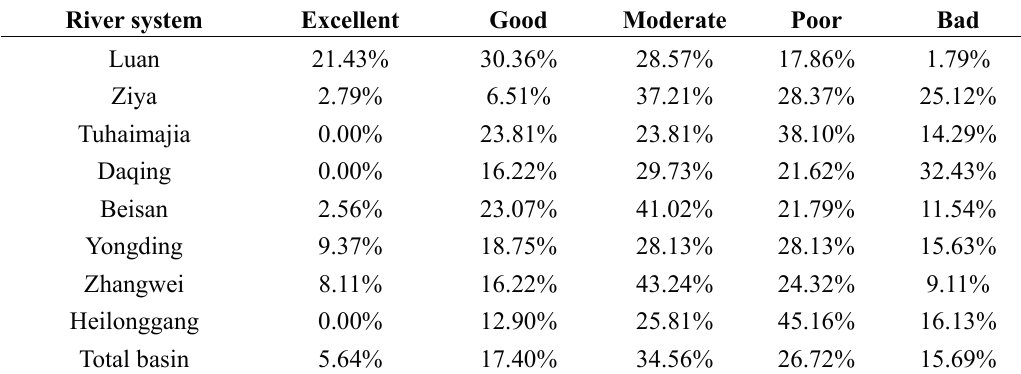
Table 1. Proportion of sites of different river habitat quality in the river systems.